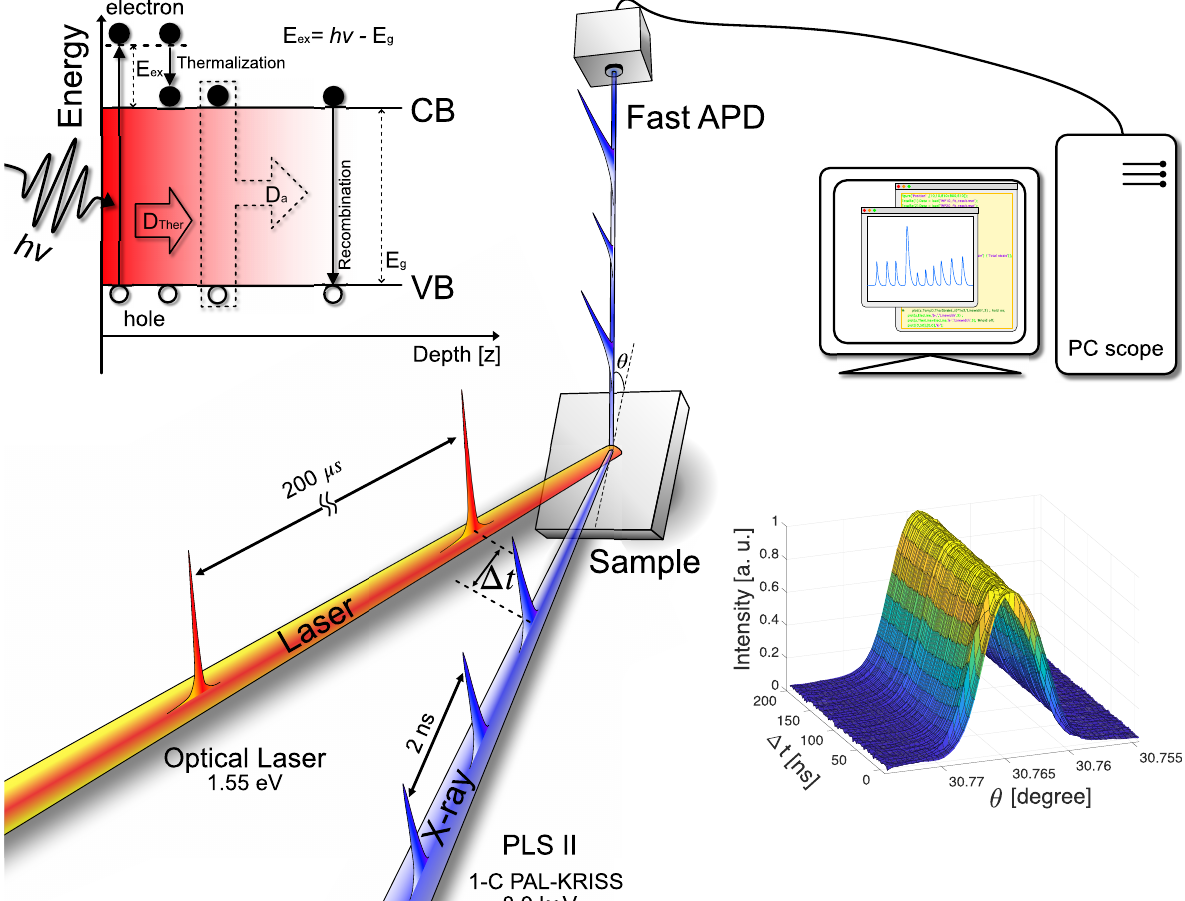
Figure 1. Schematic of time-resolved X-ray diffraction experiment at Pohang Light Source II (PLS-II). The pulse durations of X-ray and optical laser are 50 ps and 50 fs, respectively. The fast APD and on-boared digitizer allow to collect the scattered signals of each single X-ray pulses delivered with 500 MHz of electron bunch filling pattern of the storage ring. Intensity profiles of Si (0 0 4) Bragg reflections are shown in the bottom-right side. Schematic view of band structure of Si showing photo-induced dynamics in the upper-left